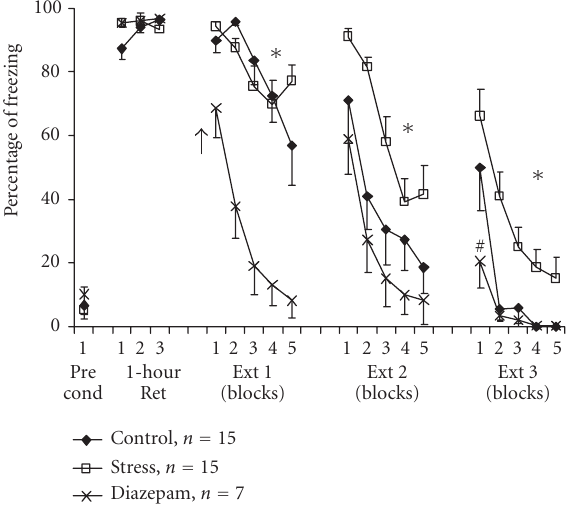
Figure 3: Diazepam overcomes stress-induced impairment of the ex- tinction of auditory fear. Rats were exposed to 3 pairings of a tone with a mild foot shock in the conditioning chamber. On the next day, control animals remained in their home cages, “diazepam” group animals were injected with diazepam (2mg/kg, IP) 20 min- utes before being placed on an elevated platform for 30 minutes, while “stress” group animals were placed directly onto the elevated platform for 30 minutes, without prior administration of the drug. Immediately afterwards, animals were taken for extinction training and were exposed to15 tones (Ext 1) with no shock. Animals were exposed to an additional 15 tones on days 3 (Ext 2) and 4 (Ext 3) with no drug or shock. There were significant di ff erences between the diazepam group and the other groups during Ext 1 ( P < . 001). On Ext 2 and Ext 3, the stress group was significantly di ff erent from the control (Ext 2: P < . 05, Ext 3: P < . 01) and the diazepam (Ext 2: P < . 01, Ext 3: P < . 001) groups. Arrow denotes time of drug infusion. The Pre cond data points indicate the amount of freezing exhibited by rats prior to commencement of fear